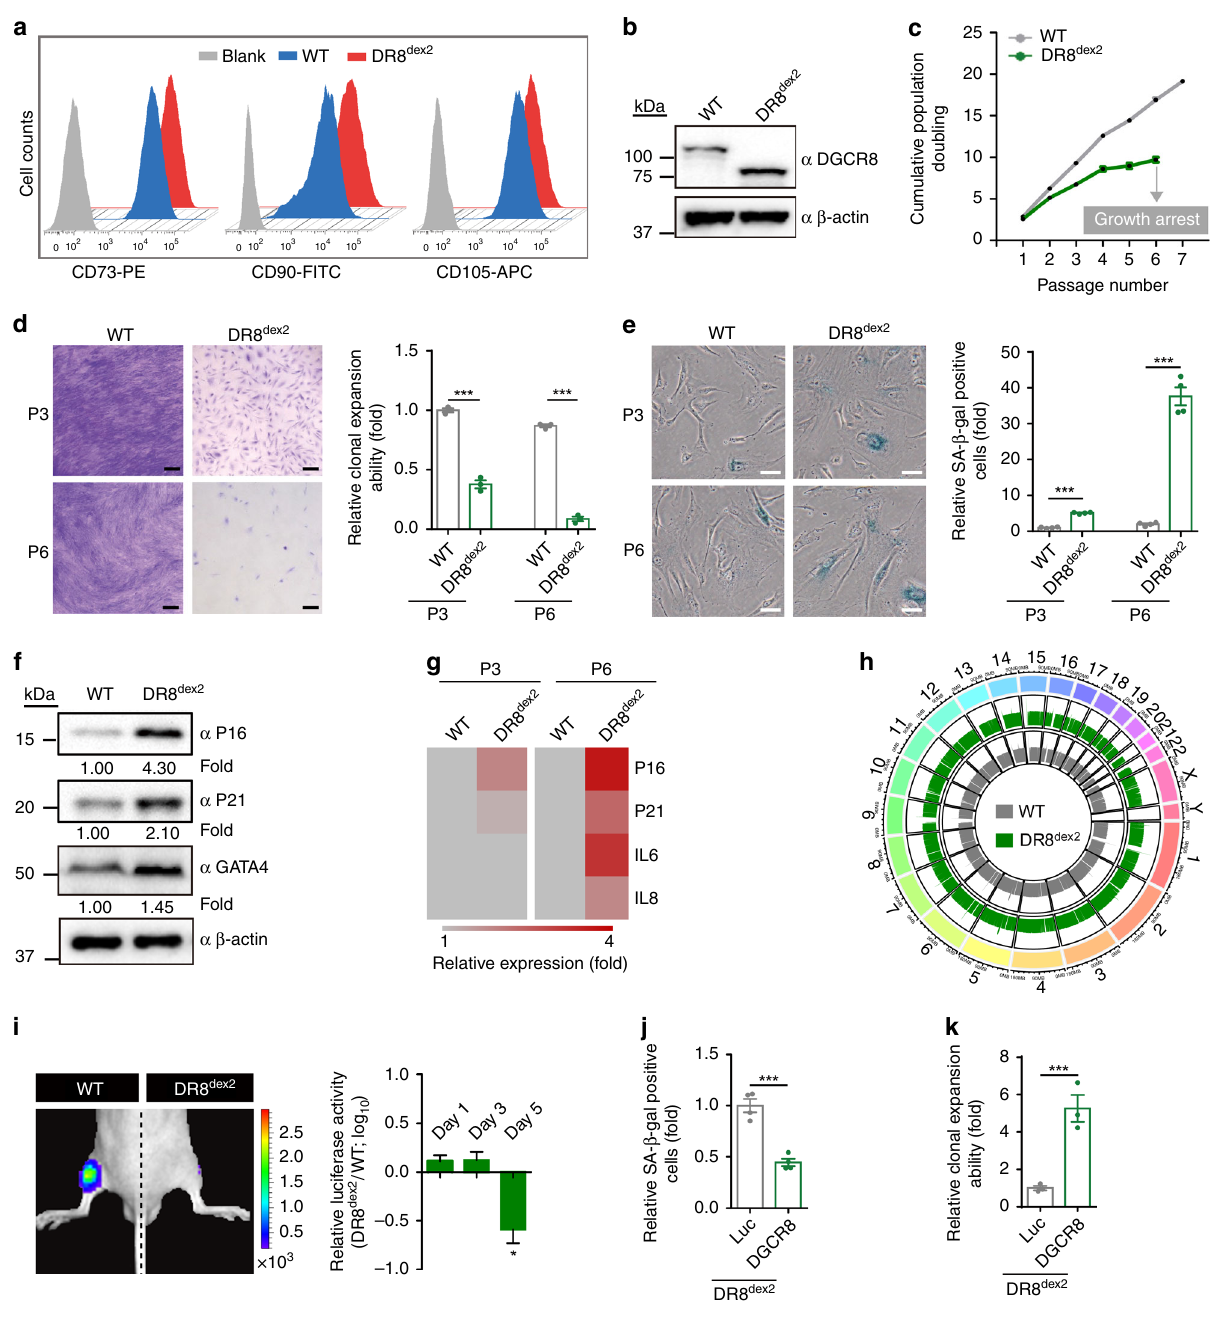
Fig. 2 DGCR8 dex2 accelerates cellular senescence in hMSCs. a FACS analysis of the MSC markers CD73, CD90, and CD105 in WT and DR8 dex2 hMSCs. b Western blotting analysis of DGCR8 in WT and DR8 dex2 hMSCs. β -actin was used as the loading control. c Growth curve of WT and DR8 dex2